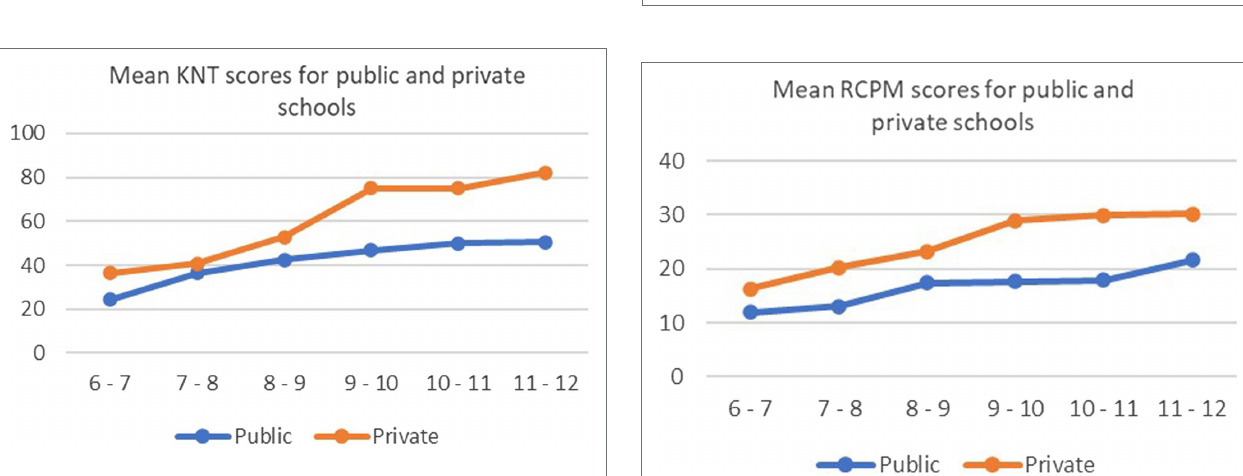
FIGURE 1 | Graph showing mean scores on RCPM for age groups by public and private schools.